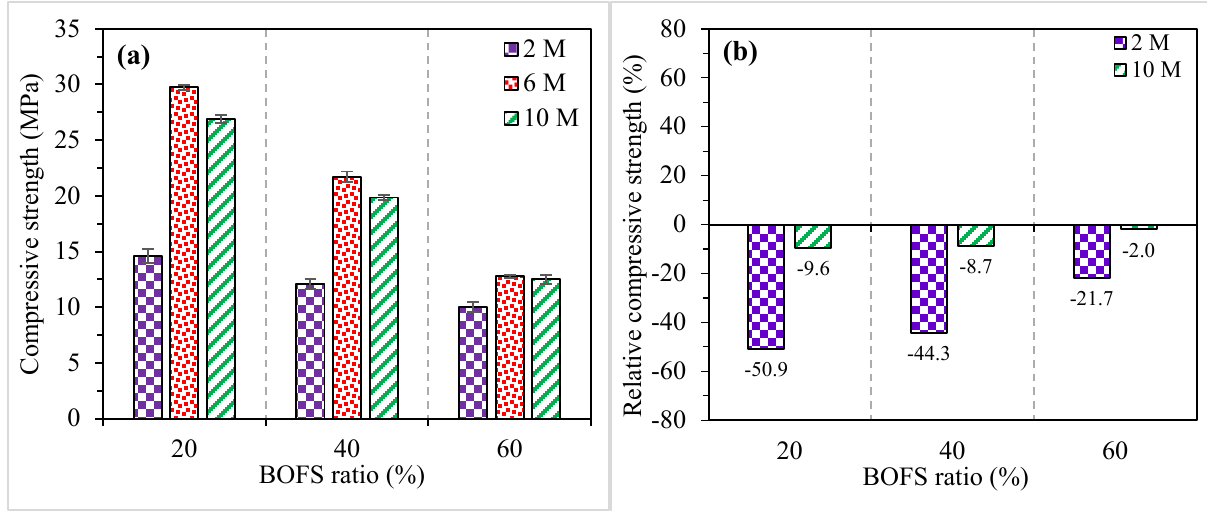
Figure 6. ( a ) Compressive strength and ( b ) relative compressive strength of specimens in comparison with 6M.